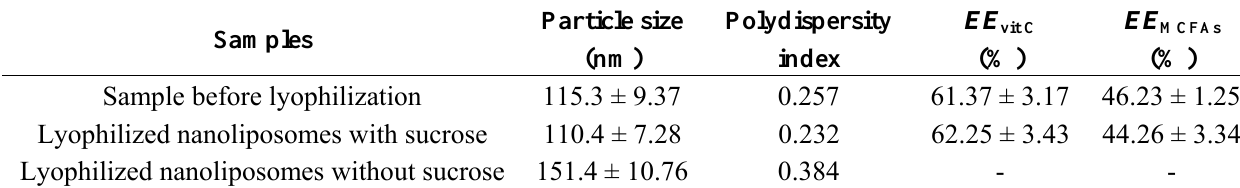
Table 1. The effects of freeze-drying and sucrose on the characters of the complex medium-chain fatty acids (MCFAs)-vit C